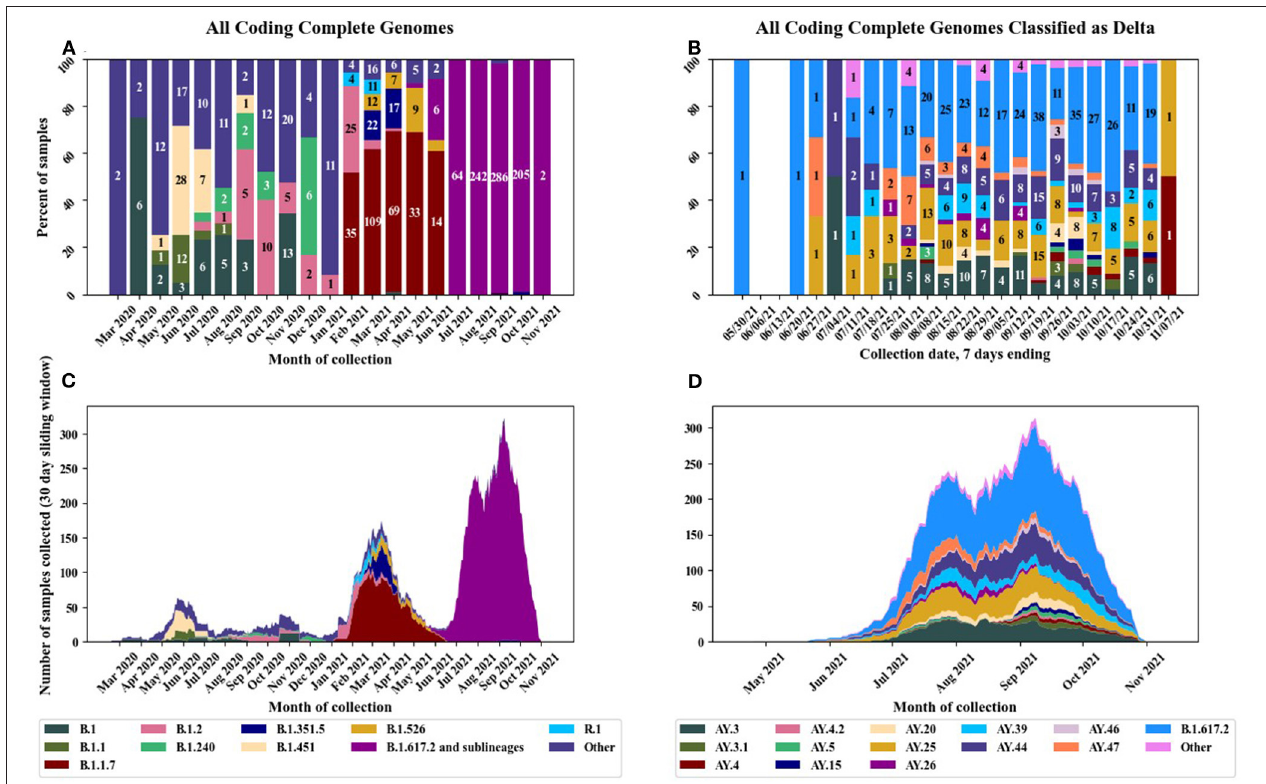
FIGURE 1 | Pango lineages of circulating SARS-CoV-2 strains in the U.S. military before and after implementation of the EUA vaccines. (A) Distribution of Pango lineages by month for all samples, (B) distribution of Delta variant sublineages by month, (C) stacked chart displaying all lineages per month, and (D) stacked chart displaying Delta variant sublineages by month.